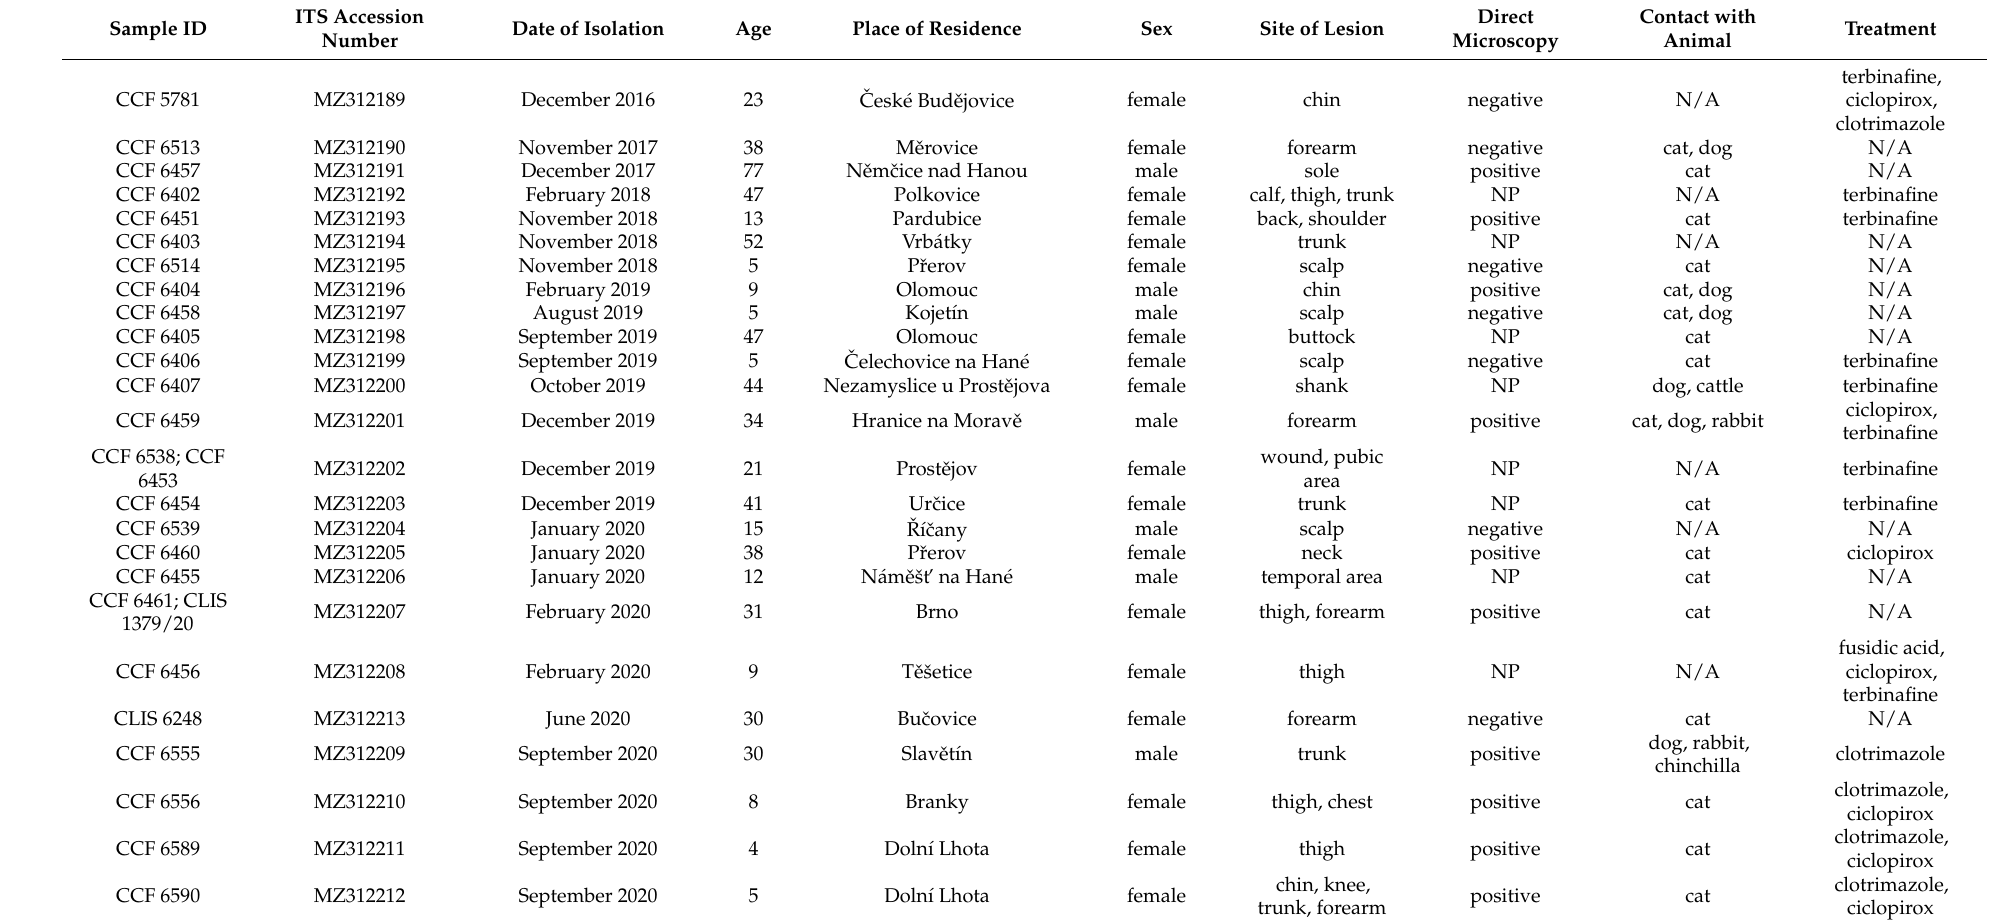
Table 1. Human isolates of Trichophyton quinckeanum examined in this